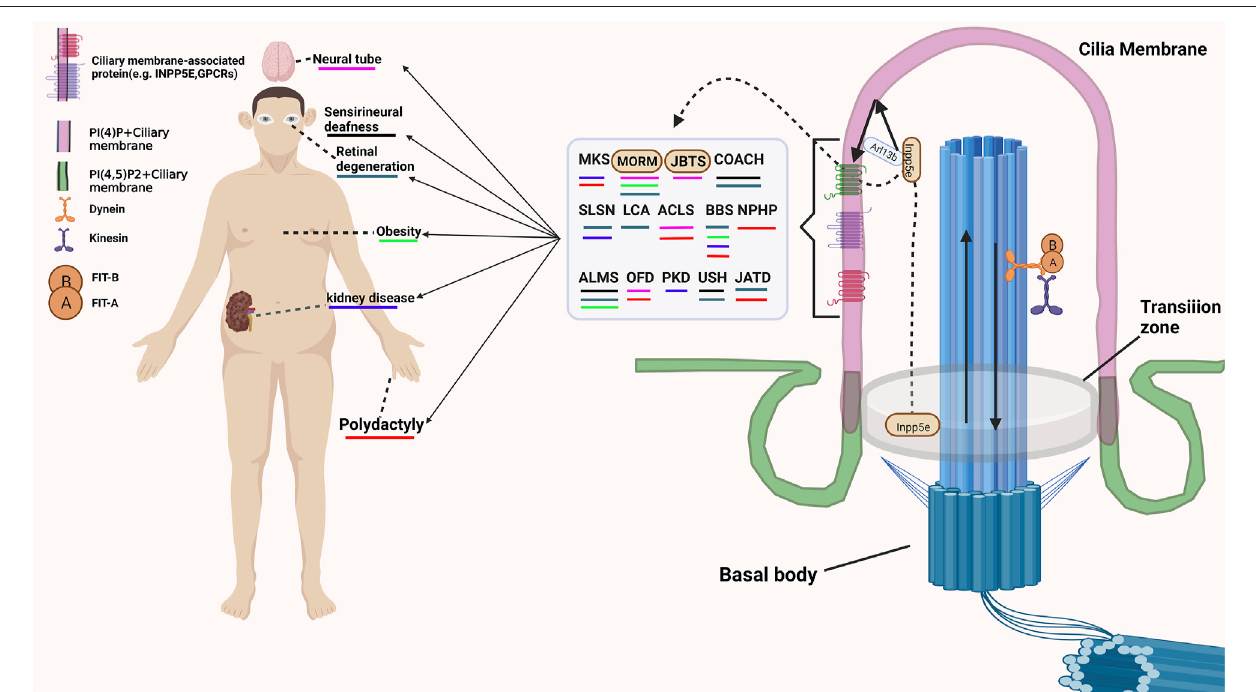
FIGURE 1 | The example of cilia associated disease and related Symptom. MKS, Meckel-Gruber syndrome; MORM, Mental retardation, truncal obesity, retinal dystrophy, and micropenis; JBTS, Joubert syndrome; COACH, Cerebellar vermis hypo/aplasia, oligophrenia, congenital ataxia, ocular coloboma, and hepatic fi brosis; SLSN, Senior-Løken syndrome Arima syndrome; LCA, Leber congenital amaurosis; ACLS, Acrocallosal syndrome; BBS, Bardet-Biedl syndrome; NPHP, Nephronophthisis,truncalobesity,retinaldystrophy,andmicropenis;ALMS,AlströmSyndrome;OFD,Orofaciodigitalsyndromes;PKD,polycystickidneydisease; USH, Usher syndrome; JATD, Jeune asphyxiating thoracic dystrophy.